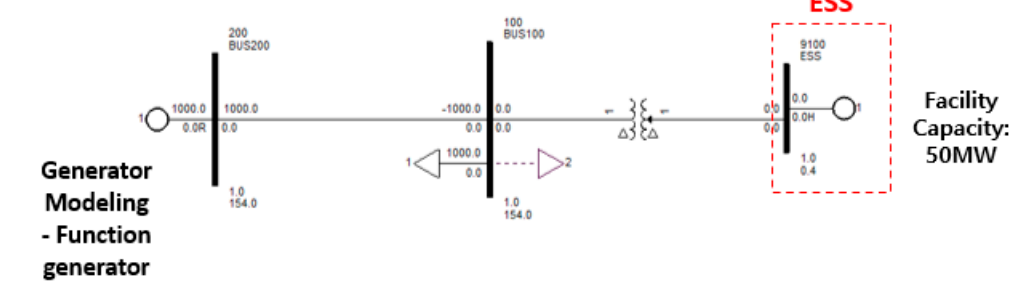
Figure 5. ESS Modeling